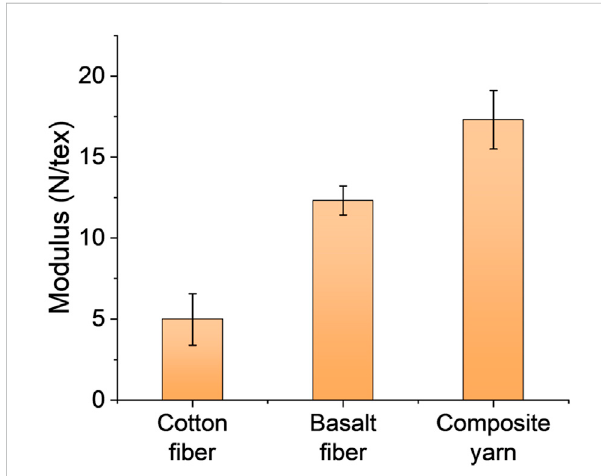
FIGURE 5 Modulus value of cotton fi ber, basalt fi lament and composite yarn.